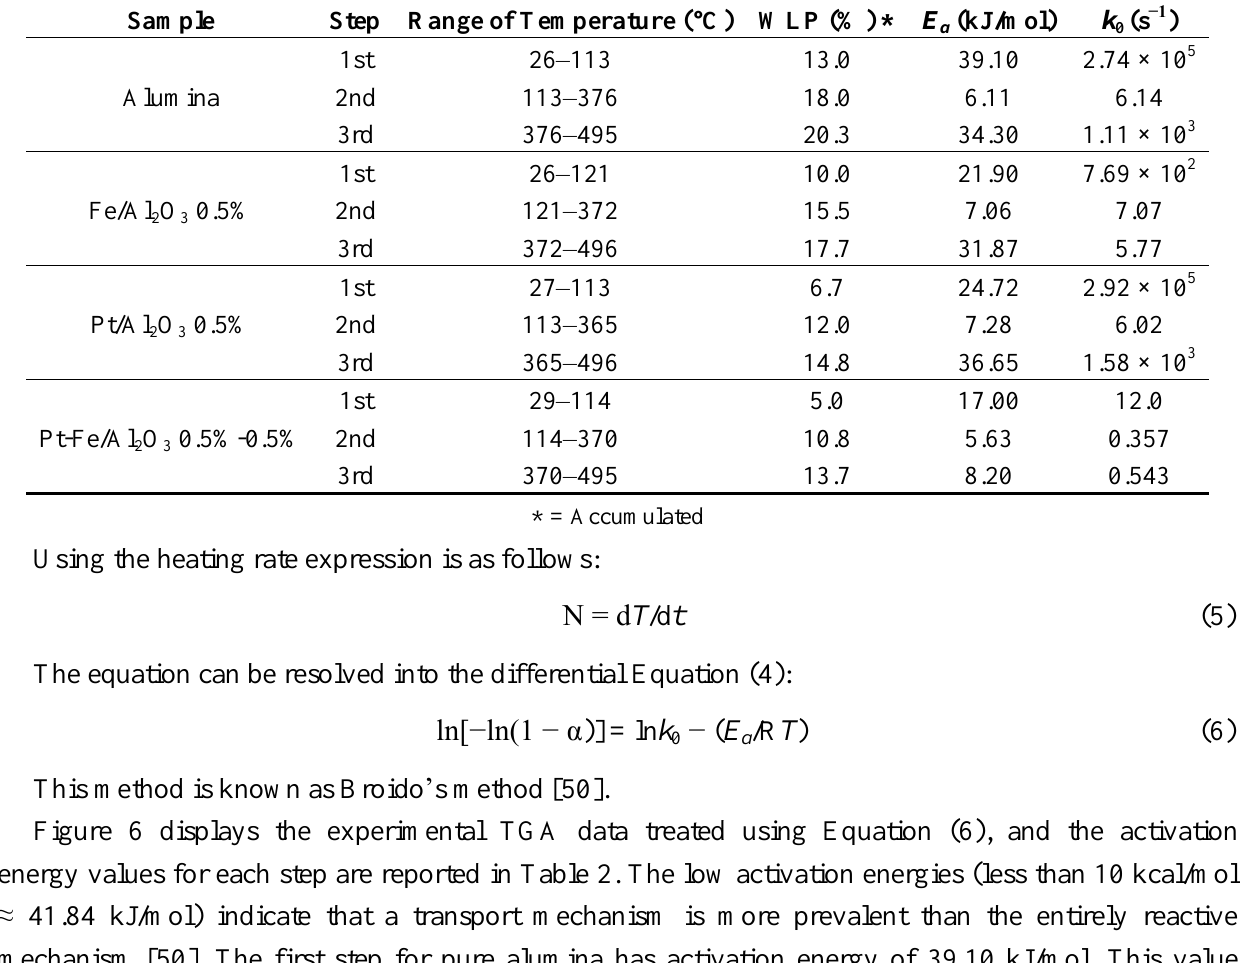
(15 mL/min) and the 2